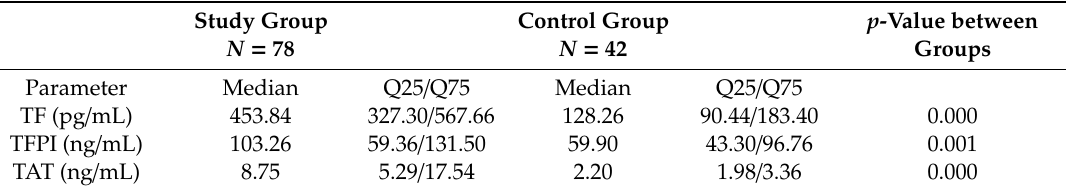
Table 2. Plasma concentrations of TF, TFPI, and TAT complex in the study group vs. the control group before four-week rehabilitation